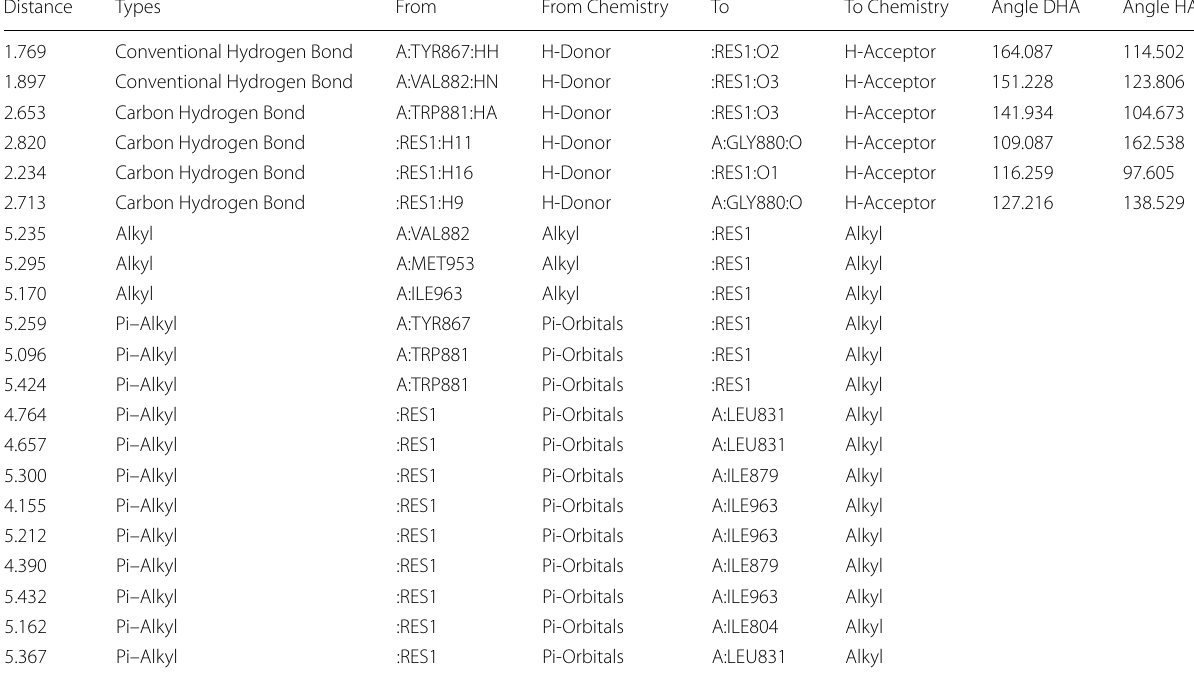
Table 4 Types of interactions in the PF-04691502-4JT6 (mTOR) receptor complex Distance